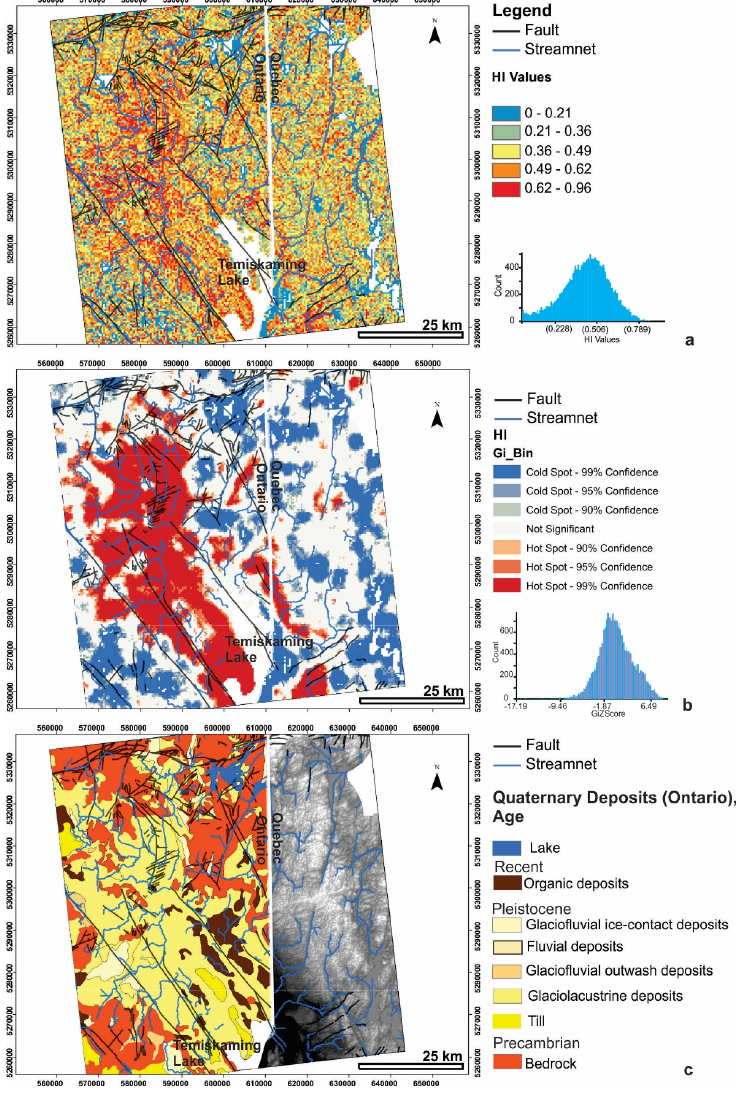
Figure 6. HI analysis for Subset area 5 with geological map; ( a ) HI map of subset 5; ( b ) Getis-Ord G analysis, also known as Hot Spot Analysis, of HI, showing the occurrence of clusters of high and low values of HI, against a map of major structural features of the area and local stream network; ( c ) summary of the major quaternary deposits and bedrock outcrops in Ontario (Ontario Geological Survey, 1997, 2011). (Note that a comparable map for Quebec was not available at the time of writing. Similar panels for the other subsets are found in the Supplementary Materials of this paper, Figures